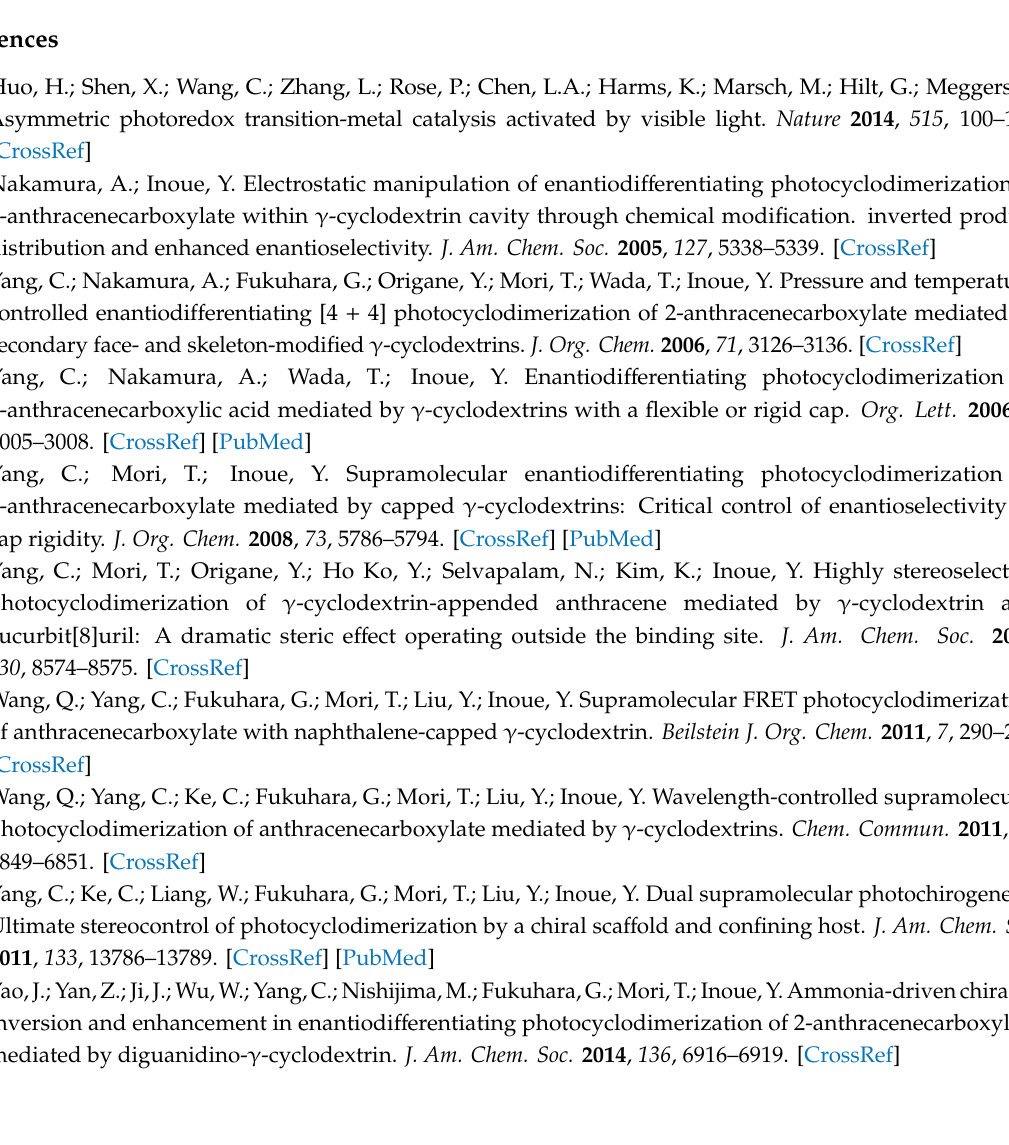
Figure S5: 1 H-NMR spectra of the mixture of Pt-2 and AC, Figure S6a: UV-vis spectra of Pt-1 , Pt-2 , and Pt-3 , Figure S6b: Normalized UV-vis spectra of Pt-2 at di ff erent concentrations, Figure S7: Emission spectra of Pt-2 , Figure S8: Phosphorescence quenching spectra of Pt-2 upon increasing AC, Figure S9: CD spectra of Pt-2 and Pt-3 , Figure S10: Job plots of Pt-2 and Pt-3 , Figure S11: Stern-Volmer plots of Pt-3 ; Table S1: photophysical properties of the sensitizers / hosts Pt-1 , Pt-2 , and Pt-3 , and Stern–Volmer quenching constant ( K SV ) between sensitizers / host and AC at 20 ◦ C. Table S2: association constants of Pt-3 and AC at a di ff erent